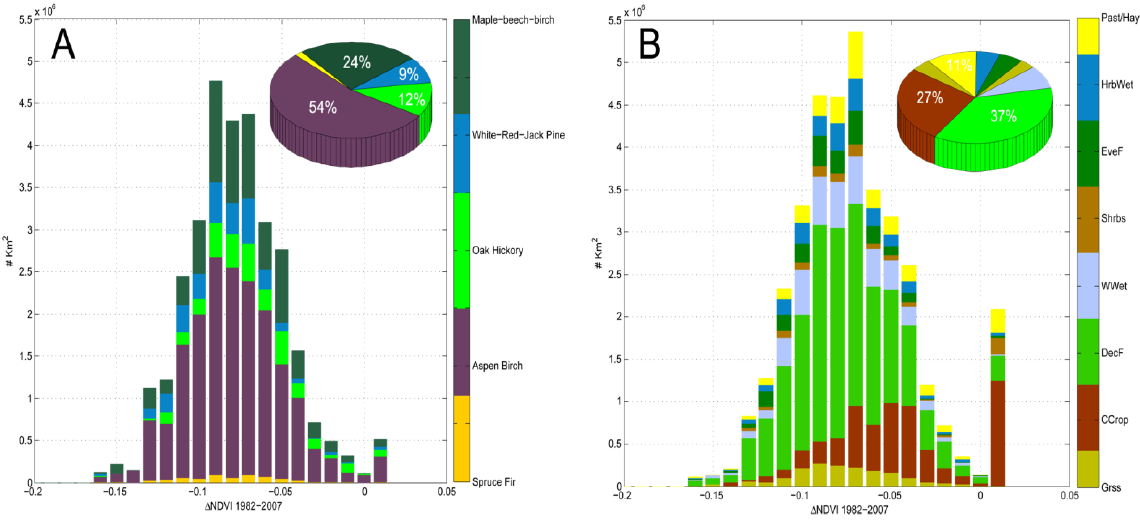
Figure 5. ( A ) AVHRR NDVI anomaly histogram stacked by forest species cover type, with the inset pie chart showing the proportion of the area by species cover type. ( B ) AVHRR NDVI anomaly stacked by 2001 NLCD types with the inset pie chart depicting the proportion of cover types with a statistically significant NDVI